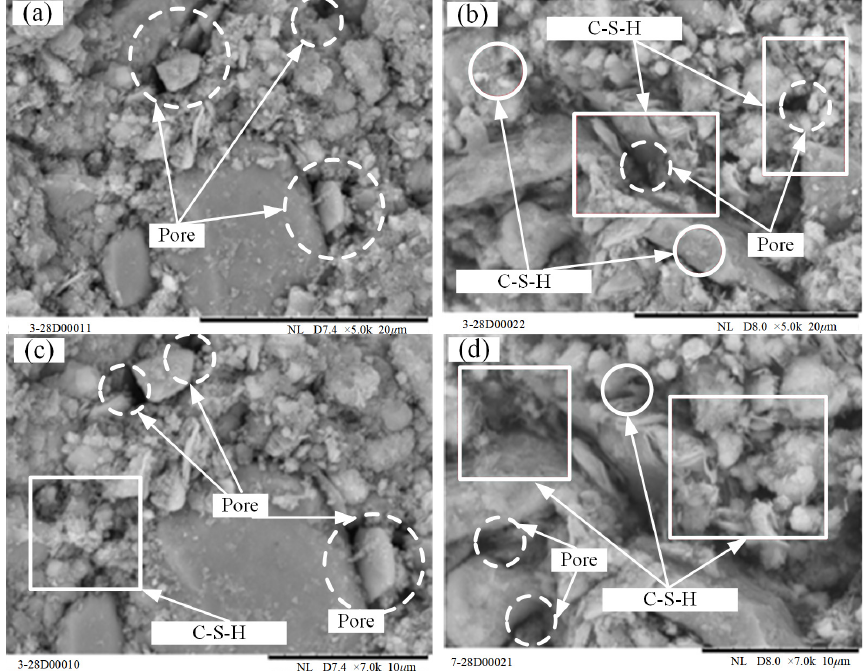
Figure 22. SEM imagines of RMLS after 28 d curing ( a ) 0% × 5.0 k ( b ) 30% ×5.0k ( c ) 0% × 7.0 k ( d ) 30% × 7.0 k. ( d ) 30% × 7.0